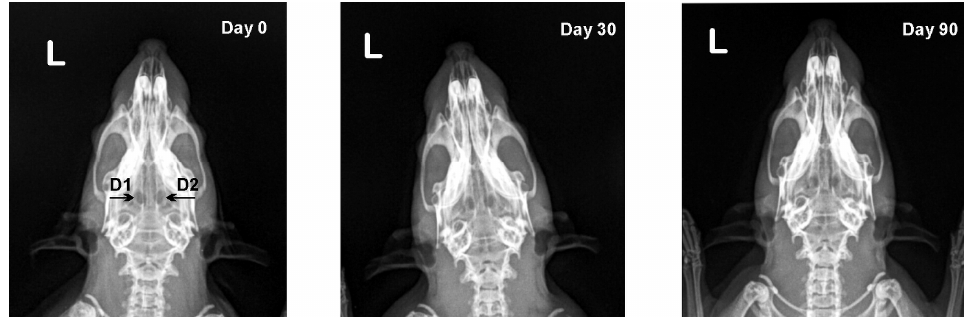
Figure 2. Serial dorsoventral radiographs of calvarial bones of rats from the first experimental group after local EPO on collagen cone (D1) and local physiological saline on collagen cone (D2) application on post-operative days 0, 30 and 90.